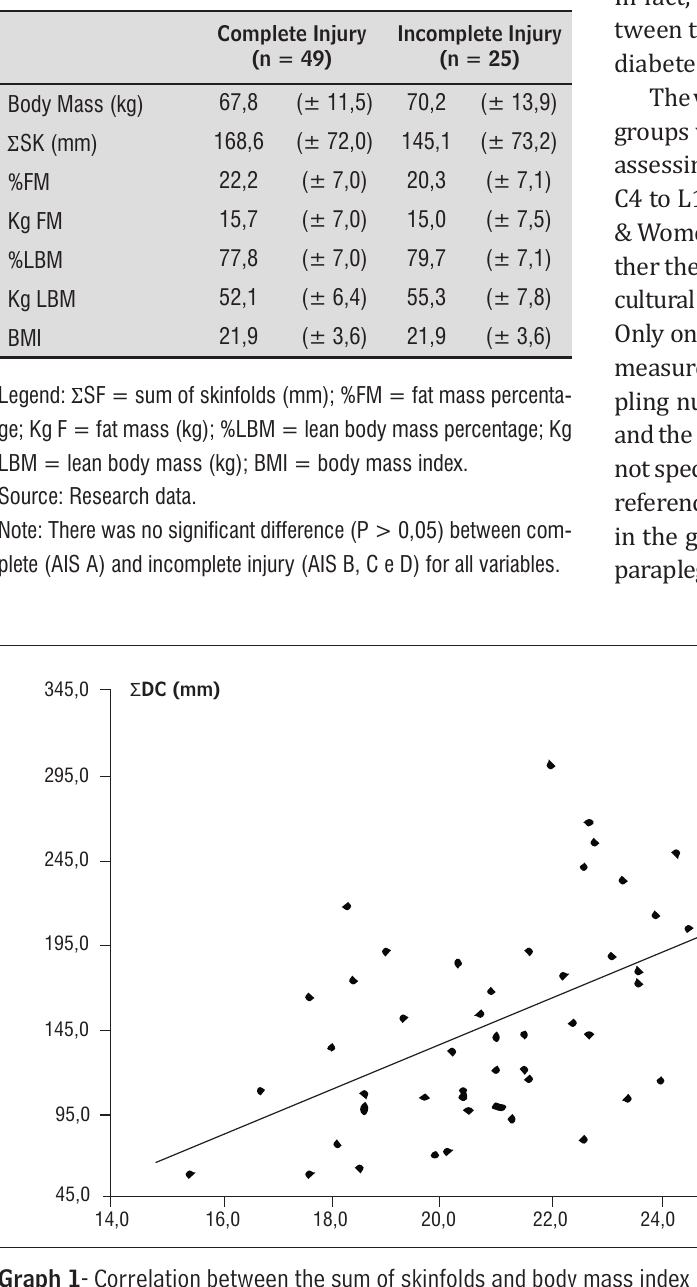
Graph 1 - Correlation between the sum of skinfolds and body mass index Souce: Research